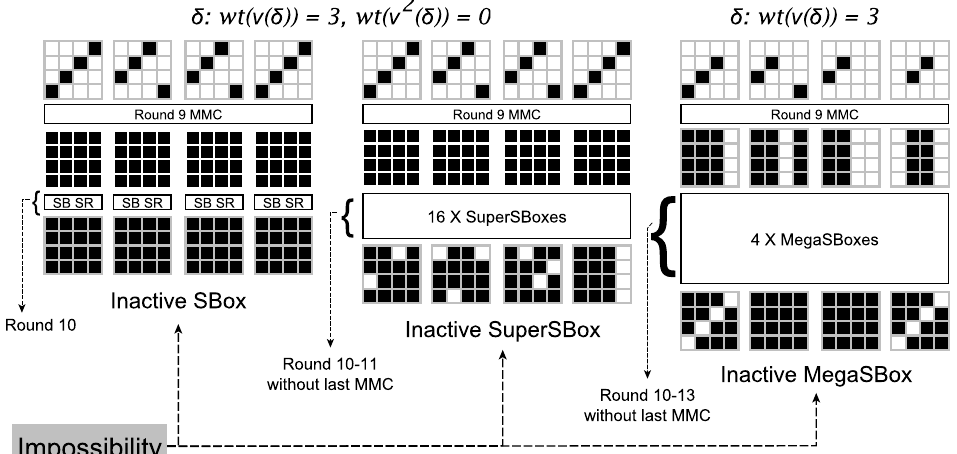
Figure 9: Different State Configurations Conforming to Claim